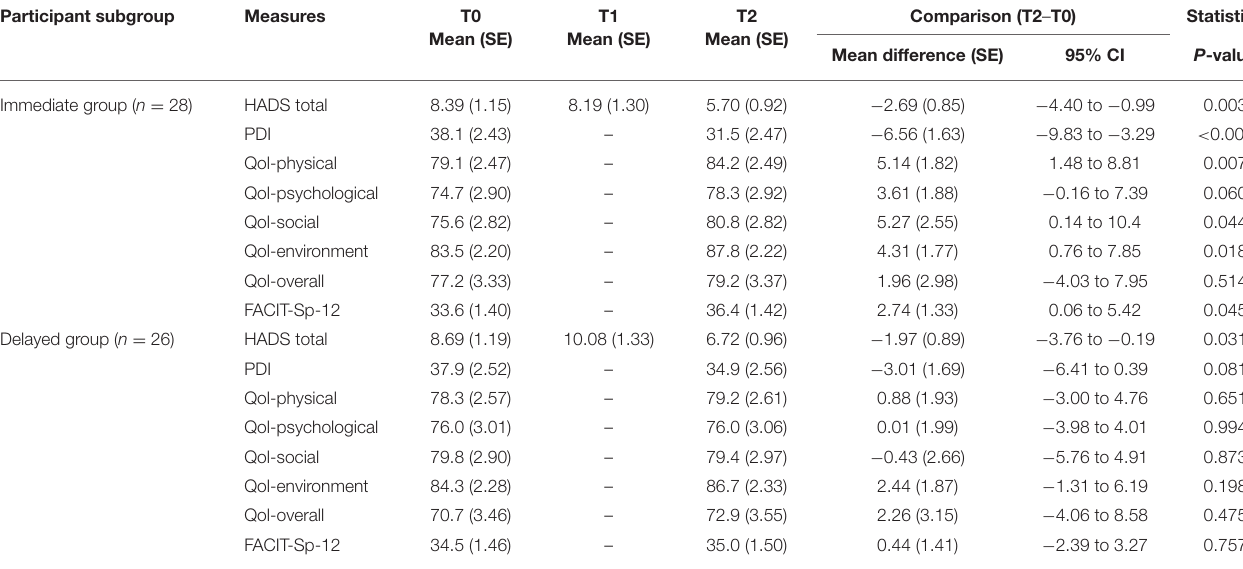
TABLE 2 | Secondary outcomes in RCT condition (immediate treatment compared to delayed treatment group). Participant